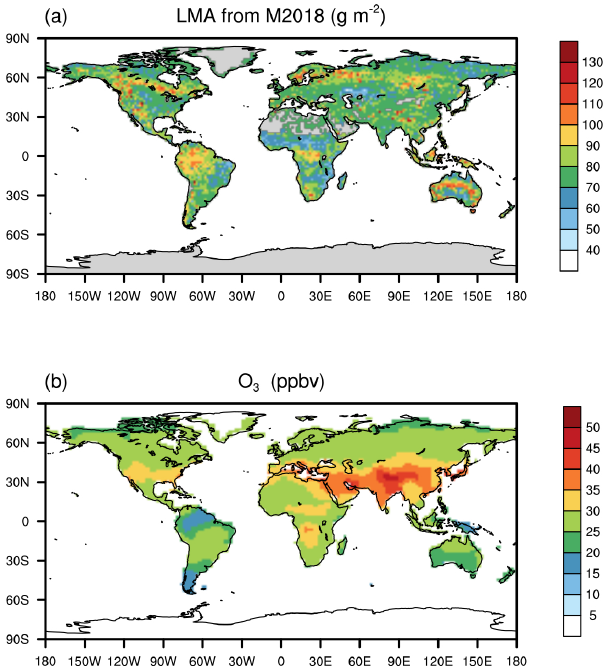
Figure 1. Global leaf mass per area (LMA) and surface ozone (O 3 ) concentrations. The (a) LMA is adopted from Moreno-Martinez et al. (2018) (M2018) and (b) annual mean O 3 is derived from TF- HTAP (Turnock et al.,